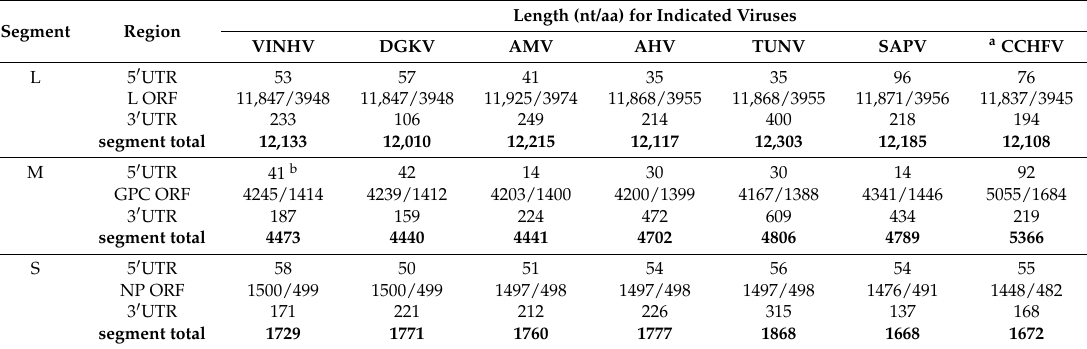
Table 1. Genome size comparisons of Vinegar Hill Virus (VINHV) and other Dera Ghazi Khan (DGK) group viruses (anti-genome sense).